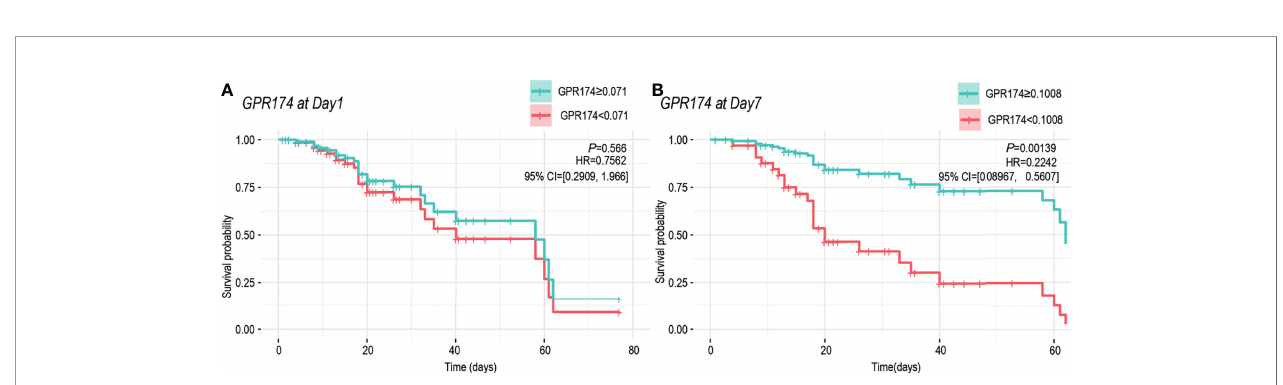
FIGURE 5 | Cox regression model for survival analysis. (A) K-M survival curve of the GPR174 mRNA expression at ICU admission. Patients were divided into higher and lower GPR174 mRNA groups according to the cut-off level of 0.071. (B) K-M survival curve of the GPR174 mRNA expression at D7 after ICU admission. Patients were divided into higher and lower GPR174 mRNA groups according to the cut-off level of 0.1008. HR: Hazard Ratio. 95% CI: 95% con fi dence